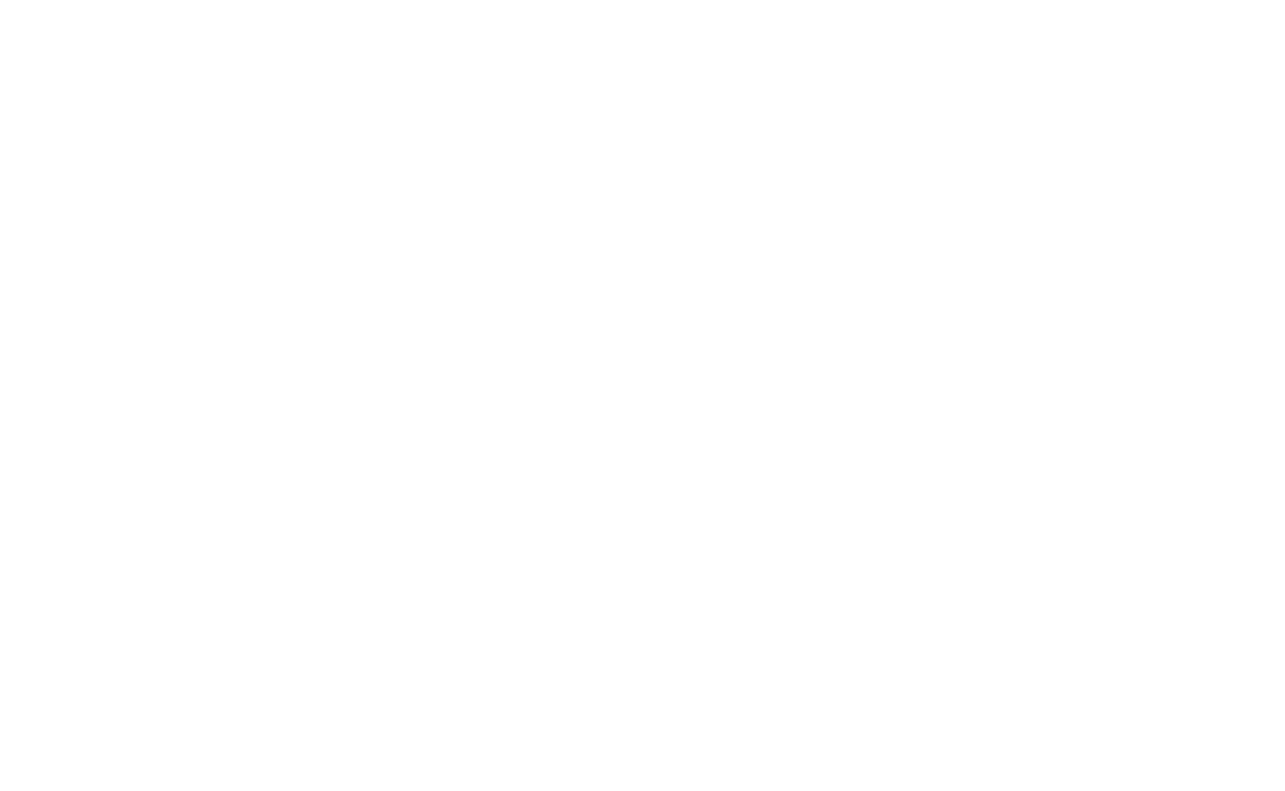
Frontiers in Psychology |